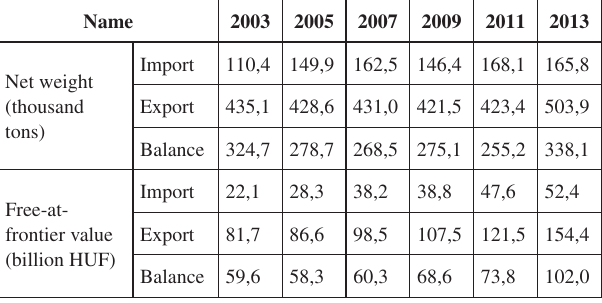
Table 2: Export-import balance of products made of vegetables, fruits, walnuts and other parts of plants